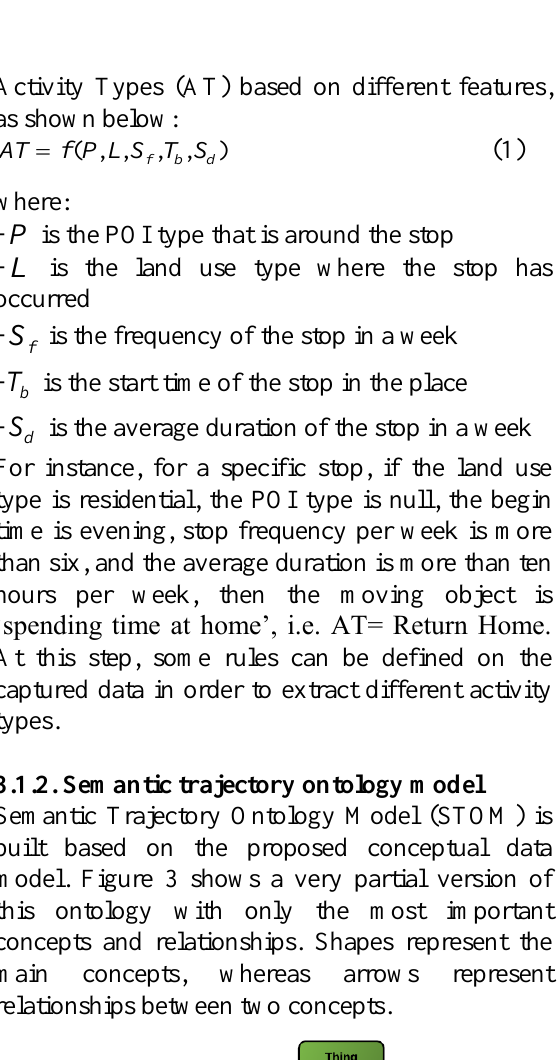
relationships between two concepts.